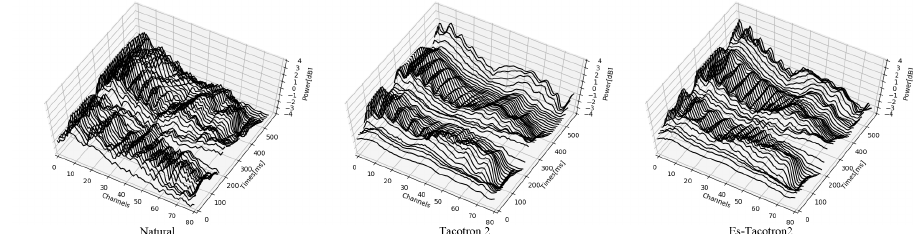
sampling rate. 15